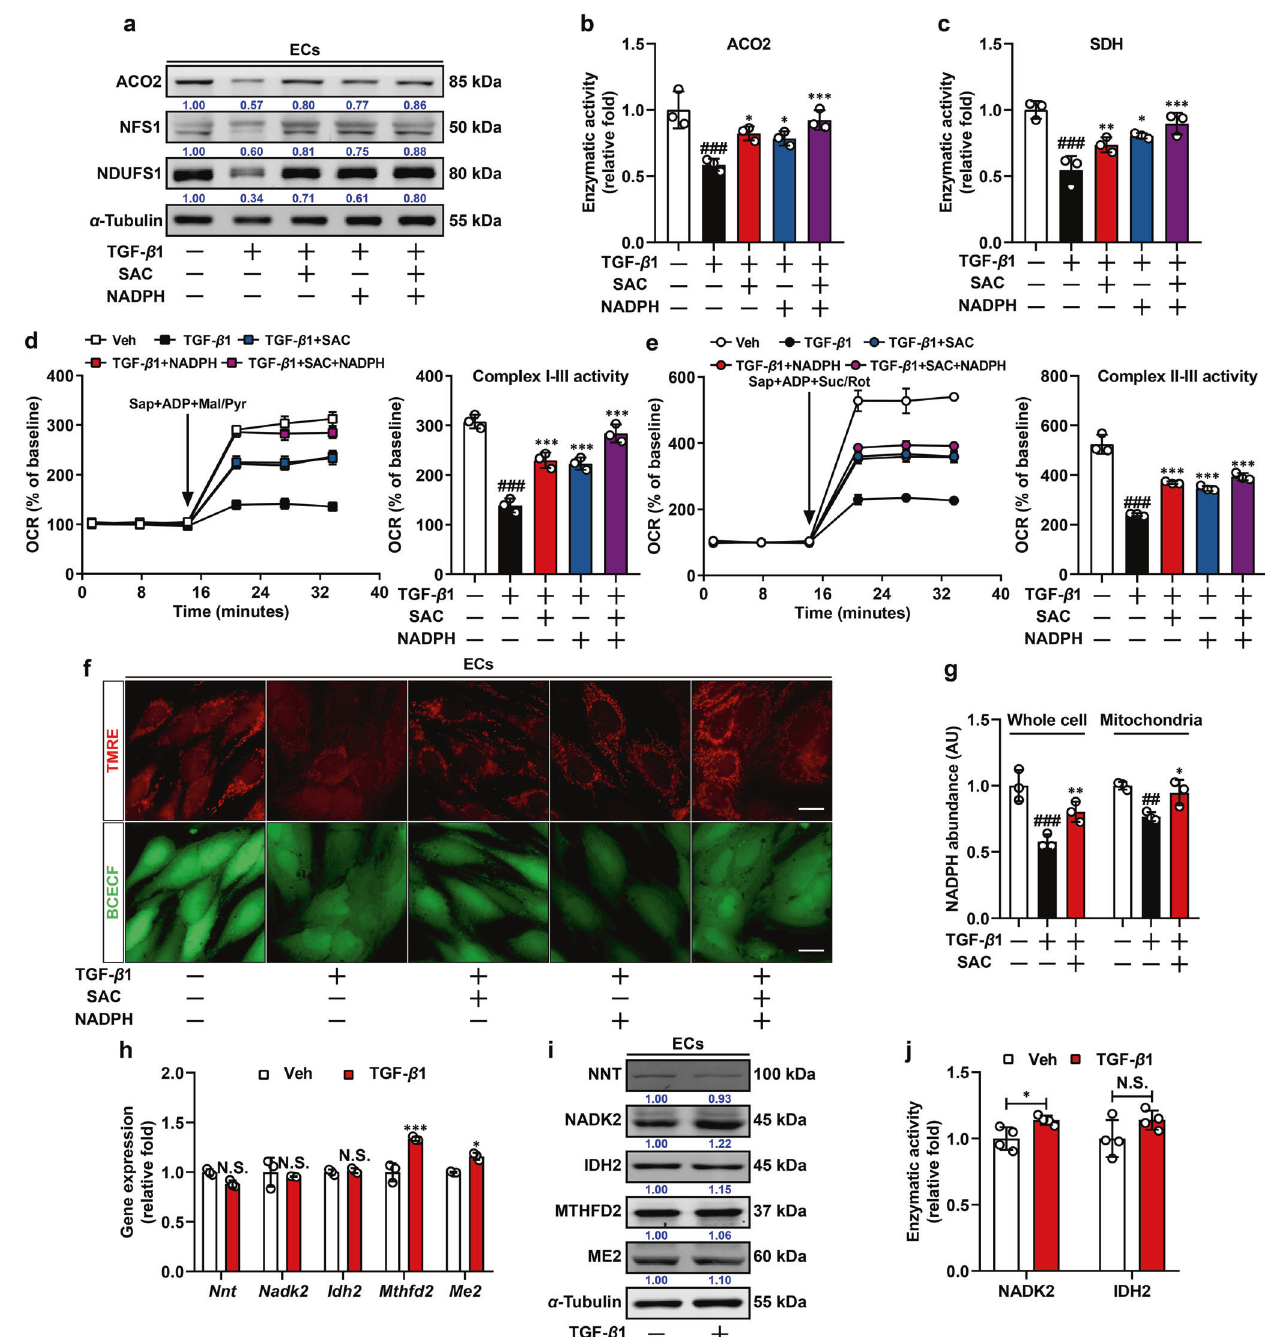
Fig. 6 SAC restores Fe-S cluster proteins via preserving cellular NADPH pool. a Immunoblot analysis of ACO2, NFS1, and NDUFS1 expression in quiescent, transformed, SAC-treated, or NADPH-transfected ECs. α -Tubulin was used as the loading control ( n = 3). b , c ACO2 and SDH enzymatic activity in quiescent, transformed, SAC-treated, or NADPH-transfected ECs ( n = 3). d , e Average complex I – III and complex II-III activity in quiescent, transformed, SAC-treated, or NADPH-transfected ECs ( n = 3). f Fluorescent counter-staining of TMRE and BCECF in quiescent, transformed, SAC-treated, or NADPH-transfected ECs ( n = 3), scale bar, 20 μ m. g Relative NADPH abundance in whole-cell and mitochondrial fractions in quiescent, transformed, and SAC-treated ECs ( n = 3). h q-PCR analysis of Nnt , Nadk2 , Idh2 , Mthfd2 , and Me2 mRNA levels in quiescent and transformed ECs. 18s RNA was used as the internal reference ( n = 3). i Immunoblot analysis of NNT, NADK2, IDH2, MTHFD2, and ME2 expression in quiescent and transformed ECs. α -Tubulin was used as the loading control ( n = 3). j NADK2 and IDH2 enzymatic activity in quiescent and transformed ECs ( n = 4). Data are represented as mean ± SD. ## p < 0.01, ### p < 0.001, N.S., nonsigni fi cant versus control group. * p < 0.05, ** p < 0.01, *** p < 0.001 versus model group ( b – e , g ) or control group ( h , j ) glycolytic fl ux to support mesenchymal transition. It is noteworthy DISCUSSION that rerouted intracellular NADPH distribution represents the Endothelial metabolism is reprogrammed during the progression interphase between enhanced glycolysis and impaired of EndoMT, and we uncover that induction of PFKFB3 drives